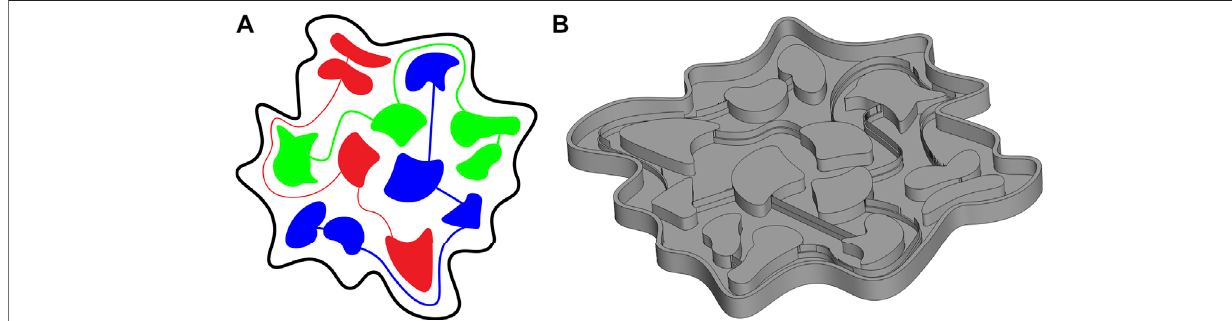
FIGURE 2 | SON Ō air chamber overview (A) and CAD rendering of the mold (B) .